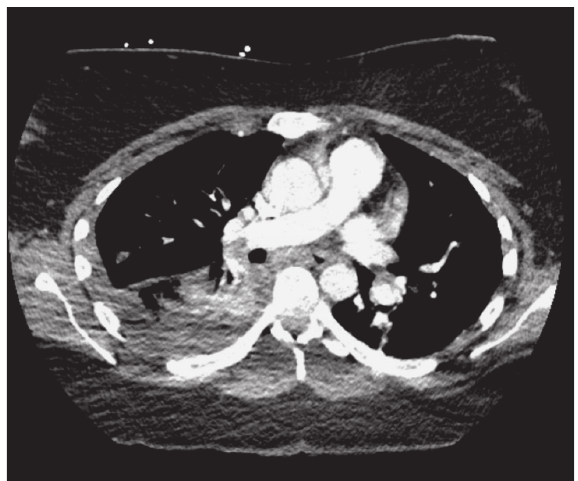
Figure 1: Pulmonary embolism at the level of the bronchus intermedius.